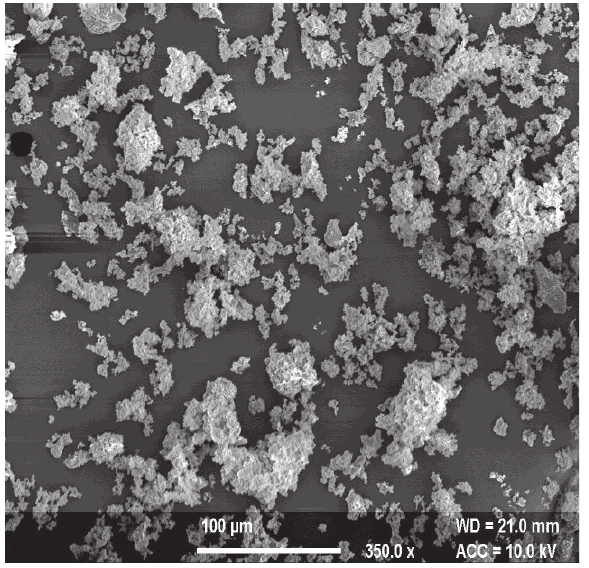
Figure 8 SEM image of the activated